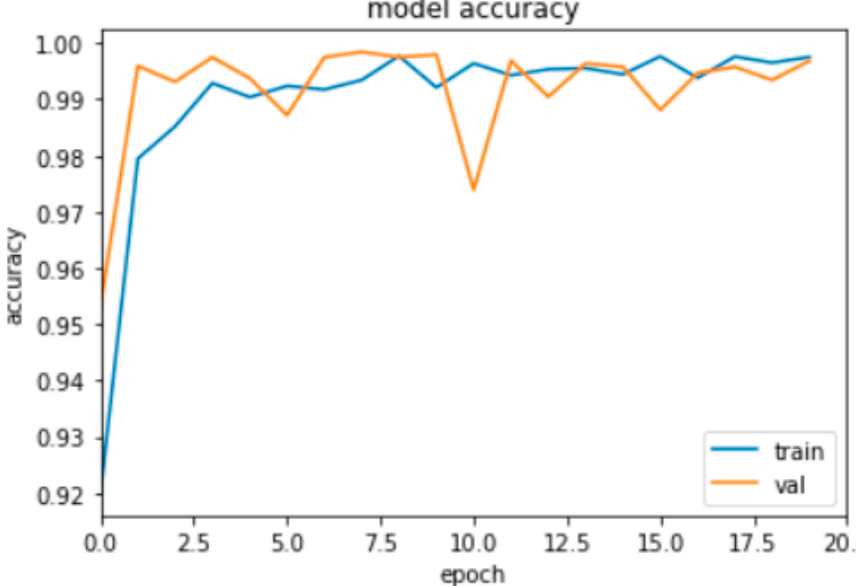
Figure 3. Training and Validation Accuracy of Image Classifier Model.